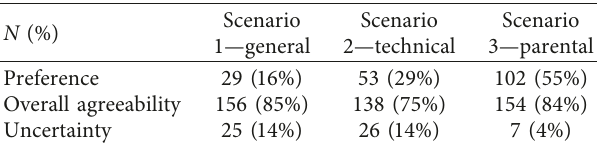
Table 3: Scenario preference, agreeability, and uncertainty.